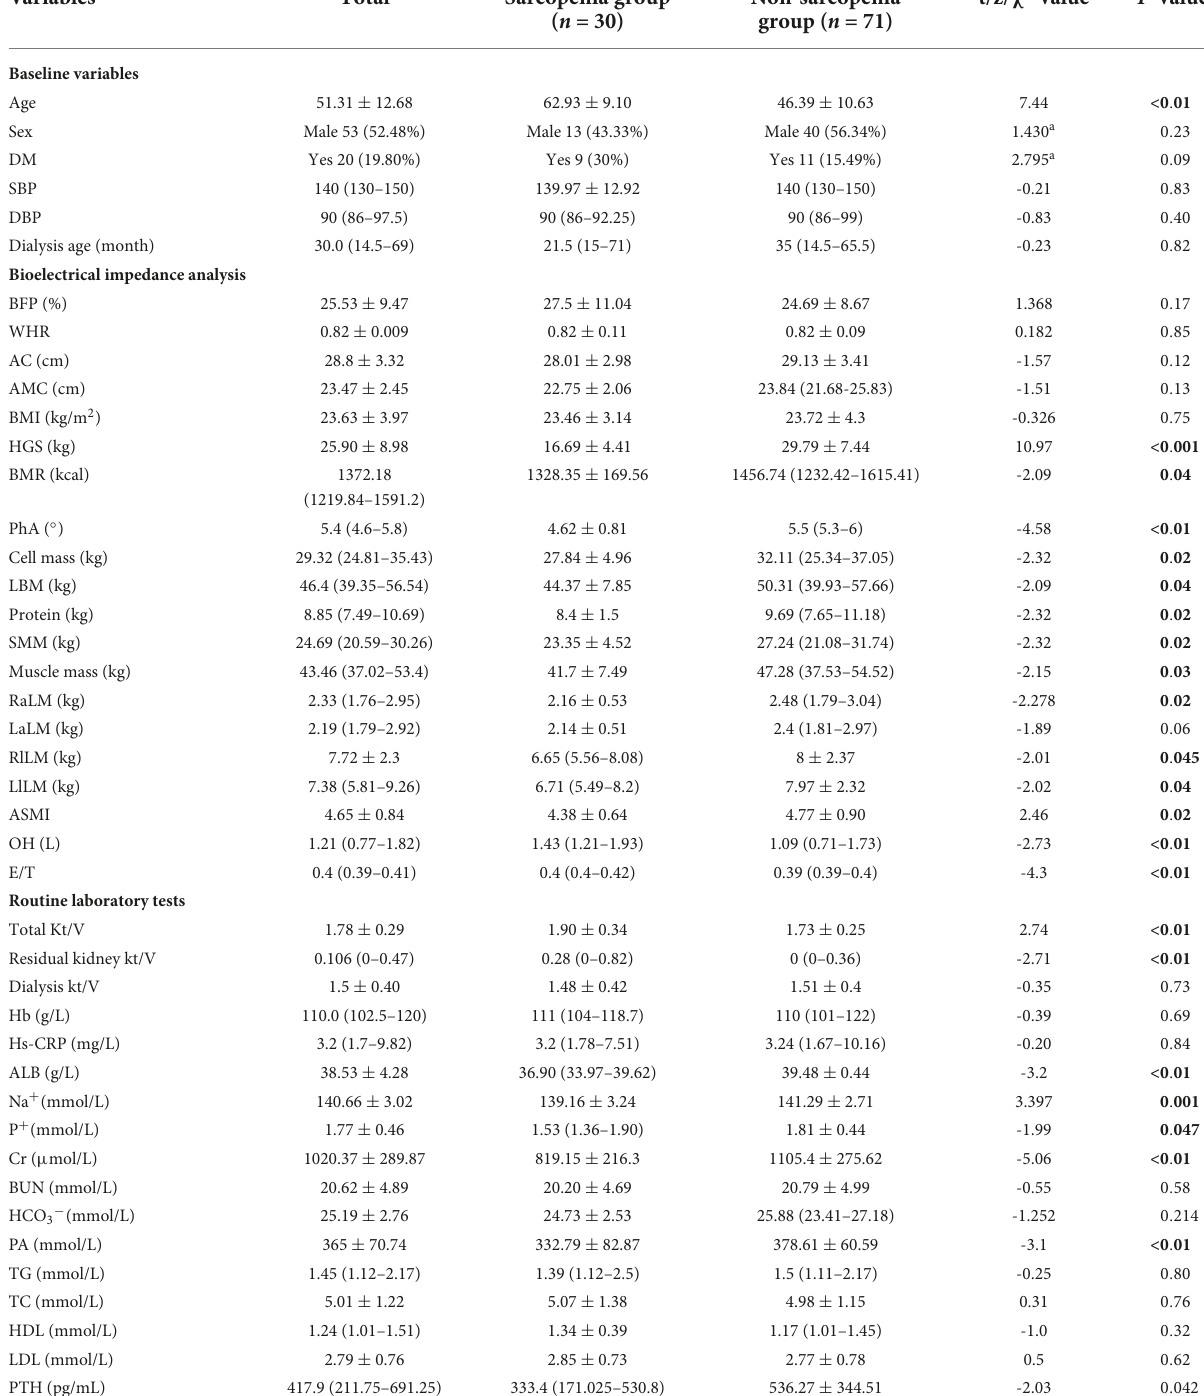
TABLE 1 Comparison of variables in sarcopenia and non-sarcopenia abdominal dialysis